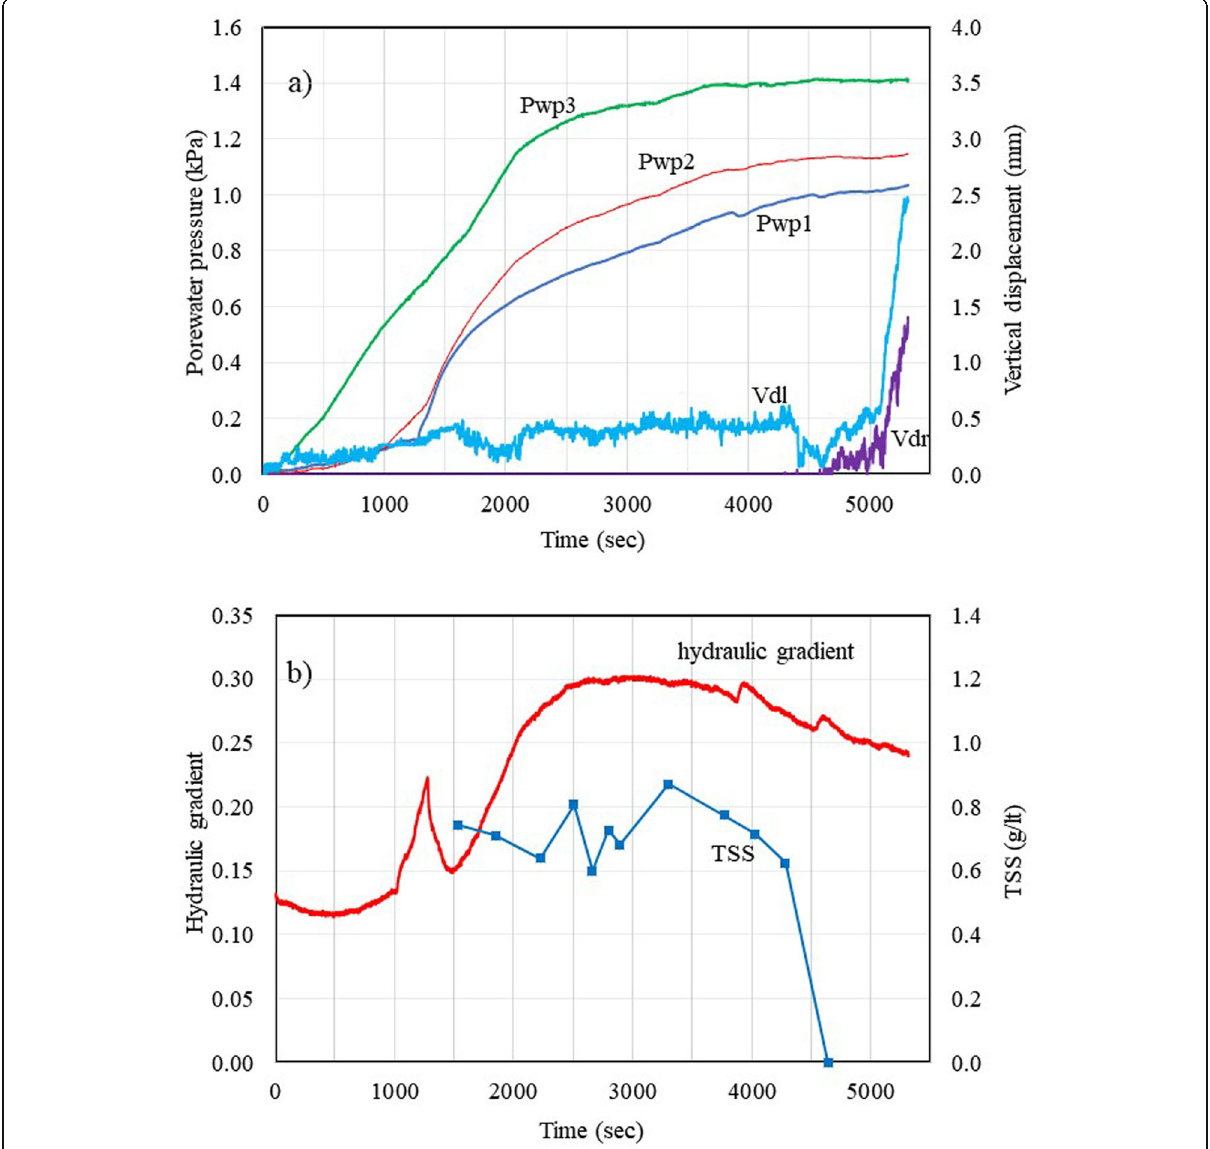
Fig. 8 Experiment results of experiment No. EXP 4NF of GII sample. a Pore water pressure and vertical displacement b Hydraulic